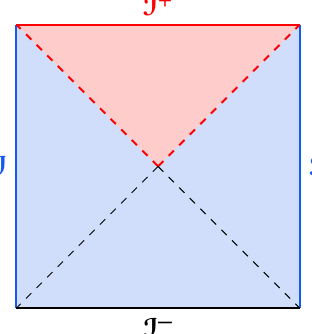
Figure 1: Penrose diagram of black hole (red) with dS